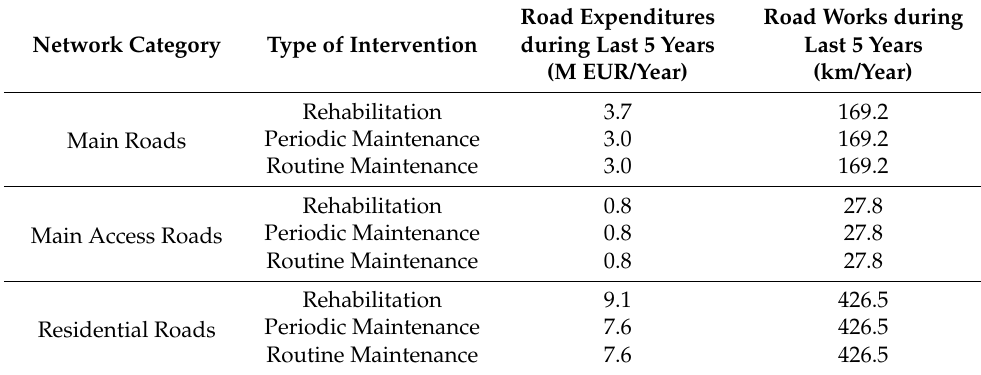
Table 6. Historical average of interventions made by Munster during the last 5